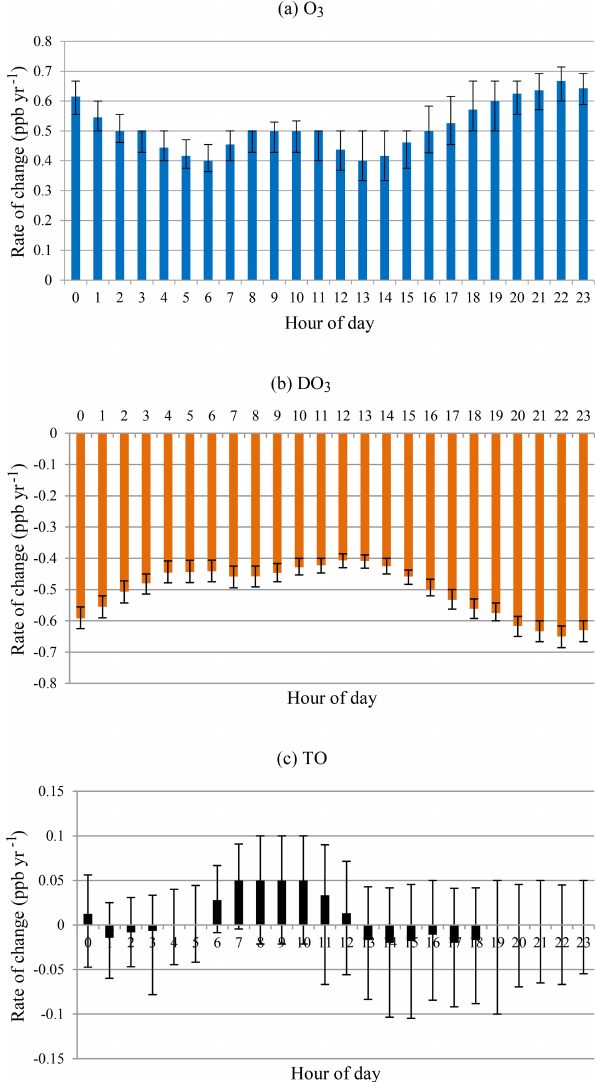
Figure 8. Rate of change by hour of day in smog season during 1996–2015 for (a) O 3 , (b) DO 3 , and (c)